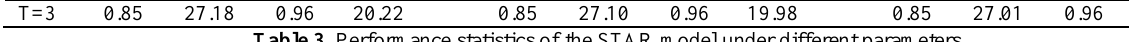
Table 3 . Performance statistics of the STAR model under different parameters